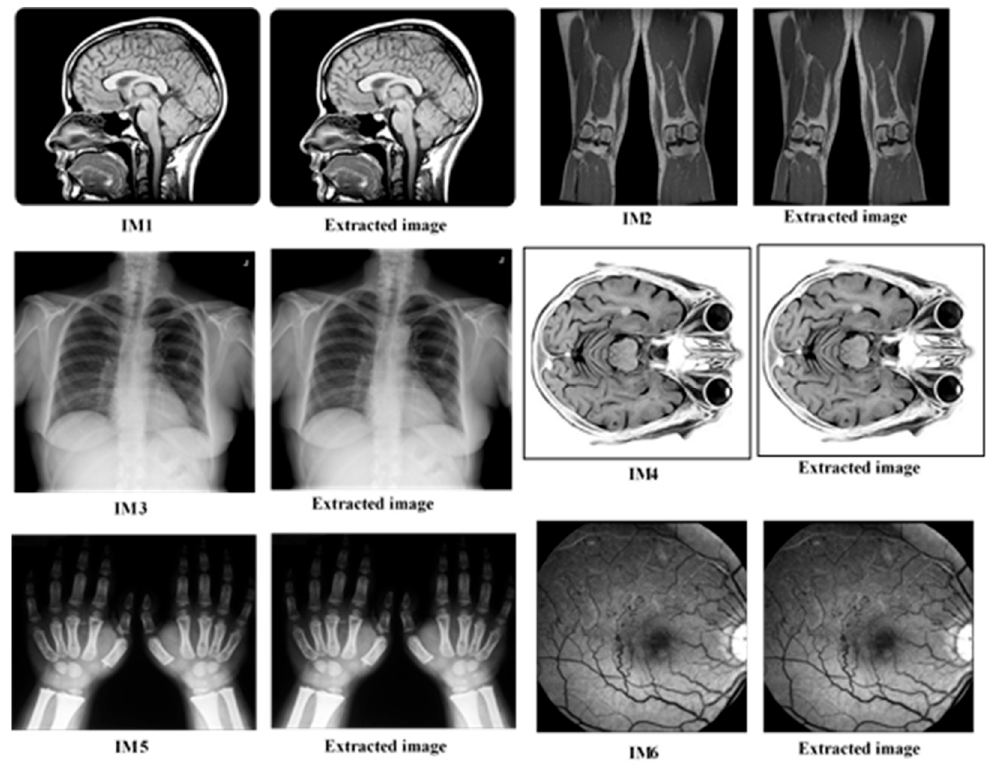
Figure 13. The original and authenticated grayscale medical test images.